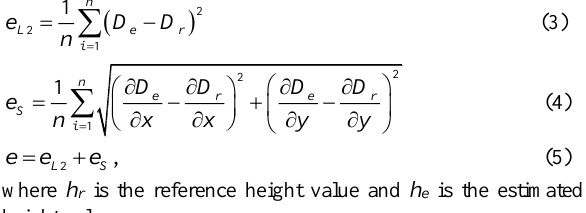
Figure 5. The study area, (a) Pleiades image in 2012, (b) LiDAR data in 2012, and (c) QuickBird image in